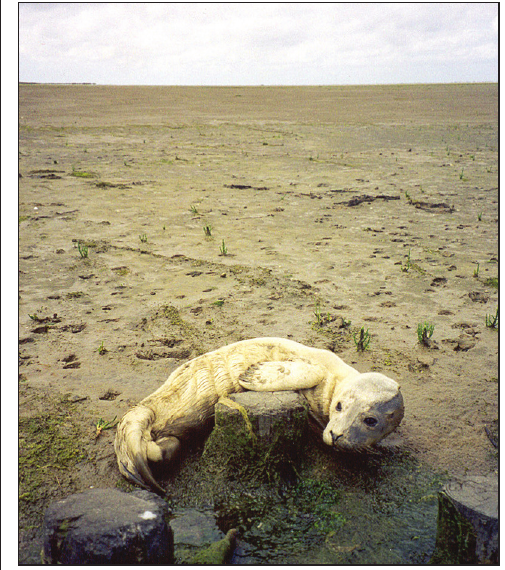
Fig. 2. Orphaned seal found at the